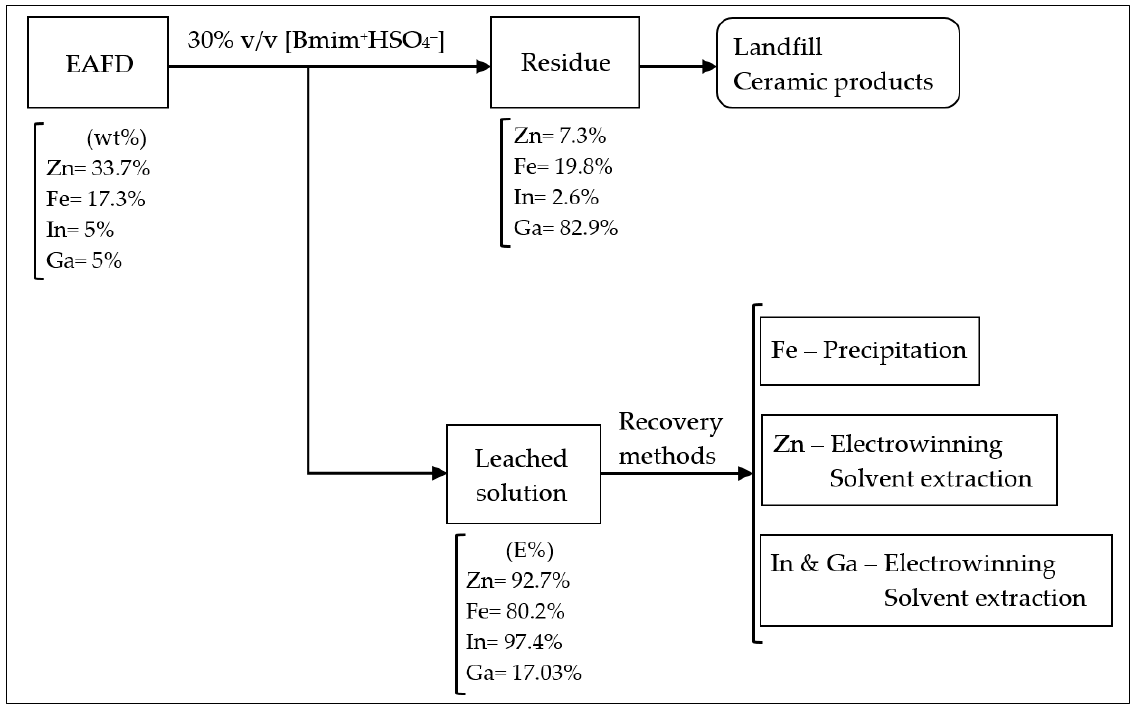
Figure 22. A scheme for the proposed treatment process(es) of EAFD leaching showing the residue and the leached solution.